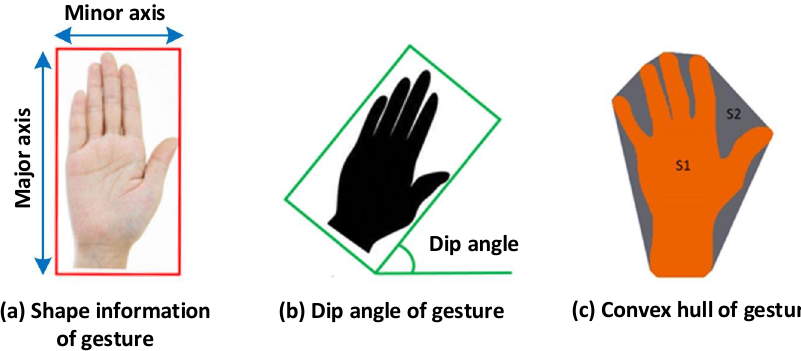
Figure 13. Description for